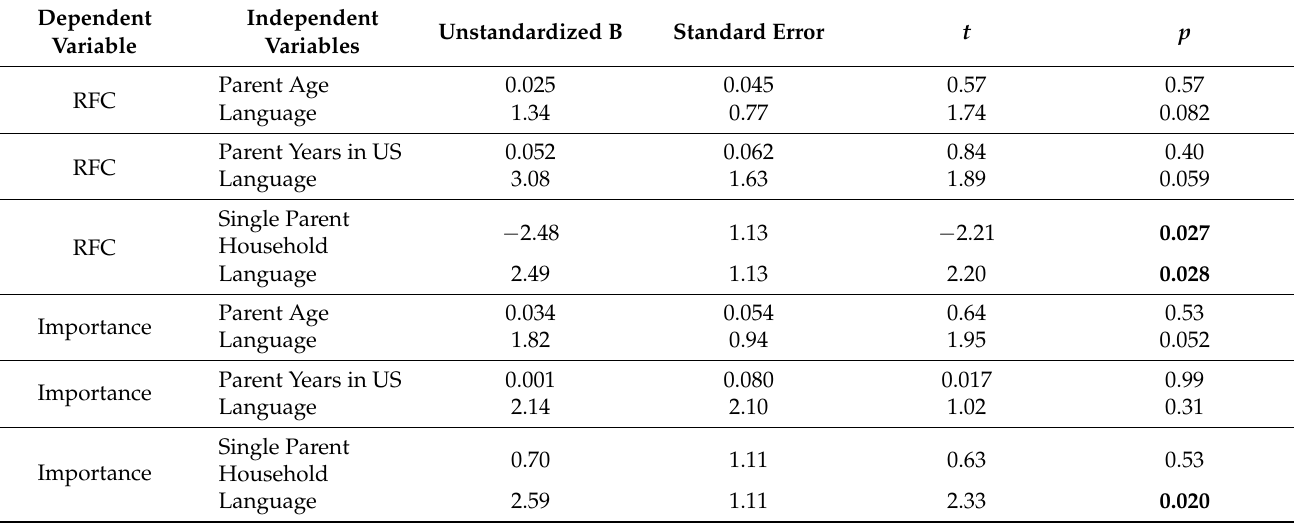
Table 3. Results from Linear Regression Analyses for Demographic Variables with Language as